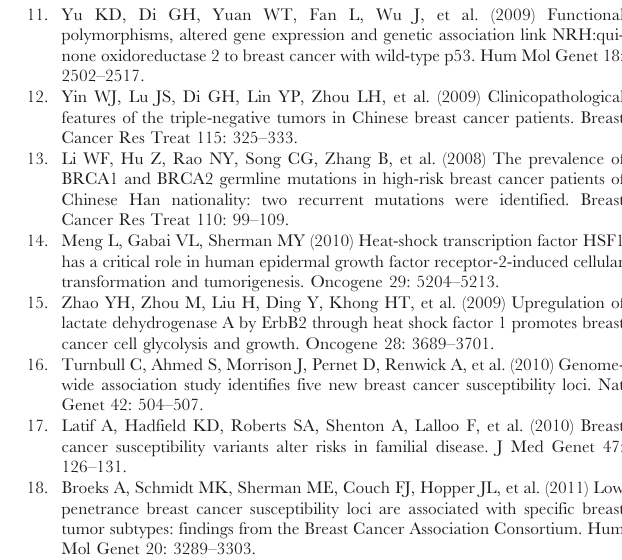
Figure S1 Different pathological tumor size according to rs4919510:C . G genotype. Patients harbouring GG genotype had larger tumor sizes compared with those carrying CC and CG genotypes. P for overall Kruskal-Wallis test =0.006. P-values for Dunn’s Multiple Comparison test of CC vs GG or CG vs GG were all , 0.05.